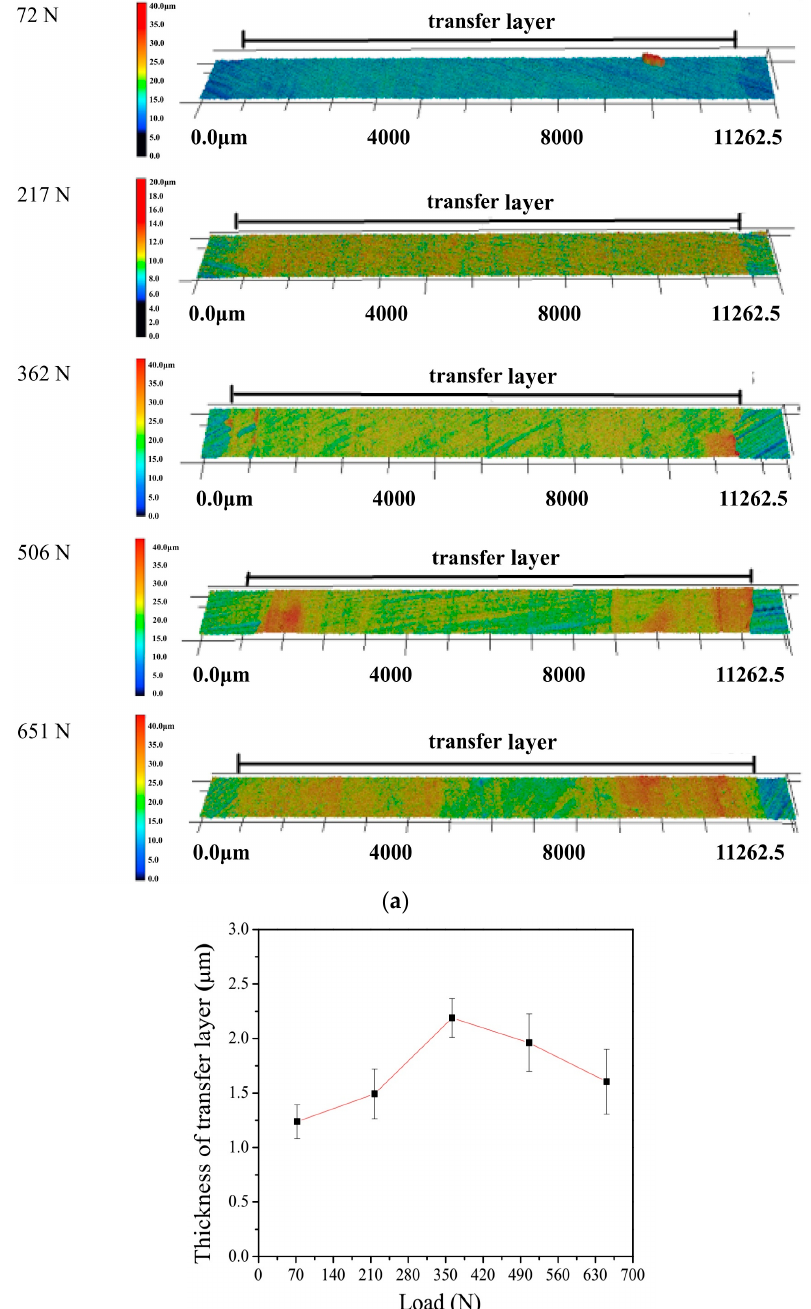
Figure 9. ( a ) The height distribution mappings of transfer layers formed under different loads; ( b ) The average transfer layer thickness vs. load.